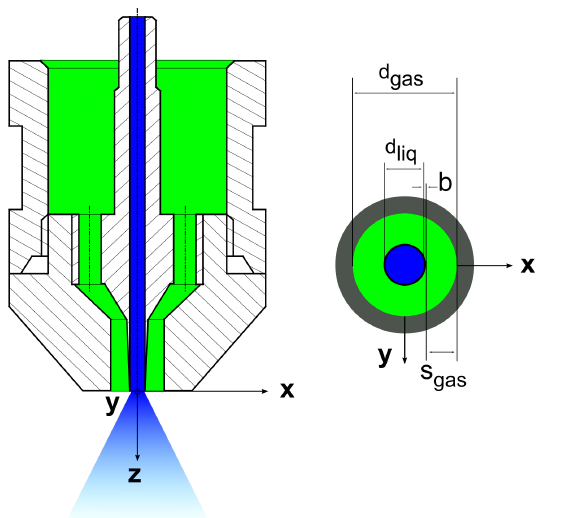
Figure 1. Schematic of a gas-assisted coaxial atomizer with central liquid jet (blue) and annular gas stream